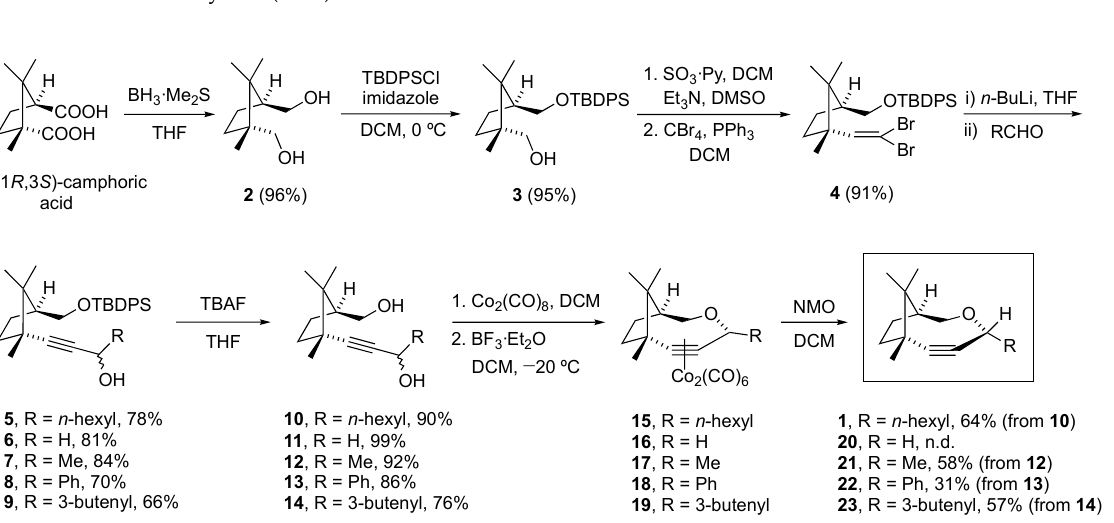
Scheme 2. Synthetic route for the preparation of strained cyclooctynes ( 1 , 20 − 23 ) starting from commercially available (+)-(1 R ,3 S )-camphoric acid. Abbreviation: n.d. = not